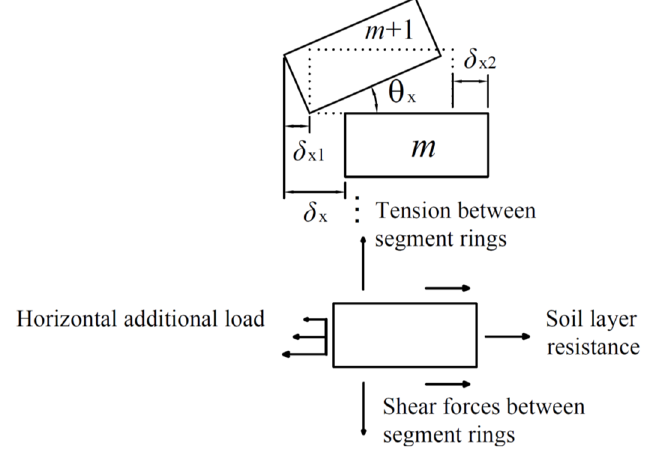
Figure 6. Calculation model for the collaborative deformation of rotation and dislocation between shield tunnel segment rings [13].